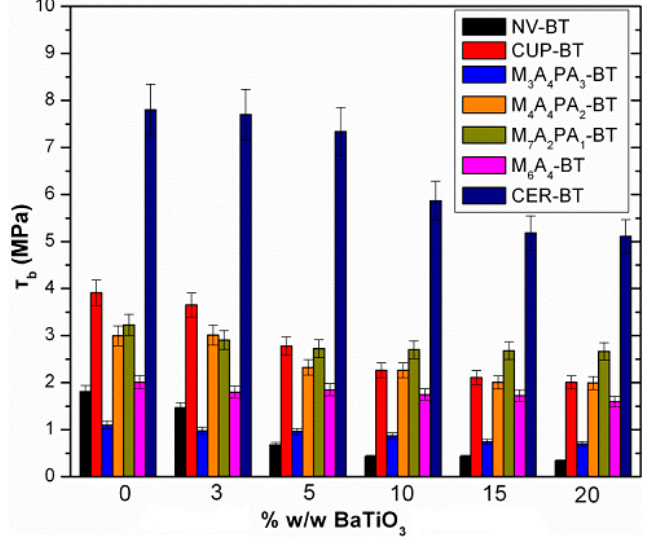
Figure 6. Shear strength values for some of the developed nano-composite specimens.